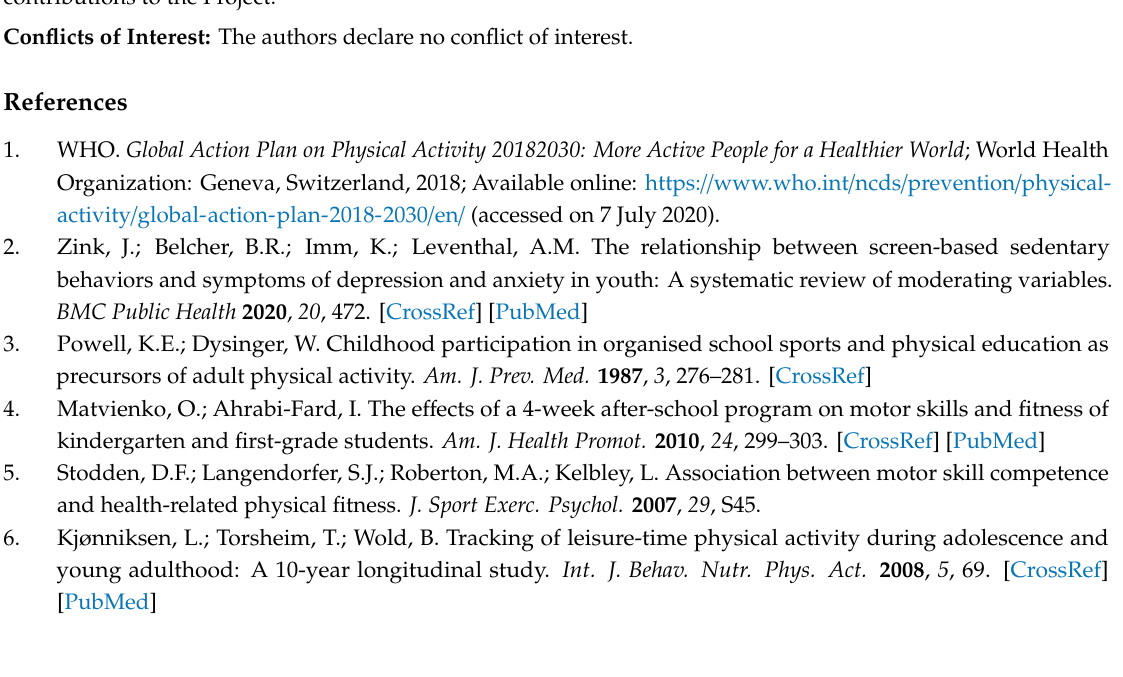
Figure S1: “General form” of Self-report questionnaires measures